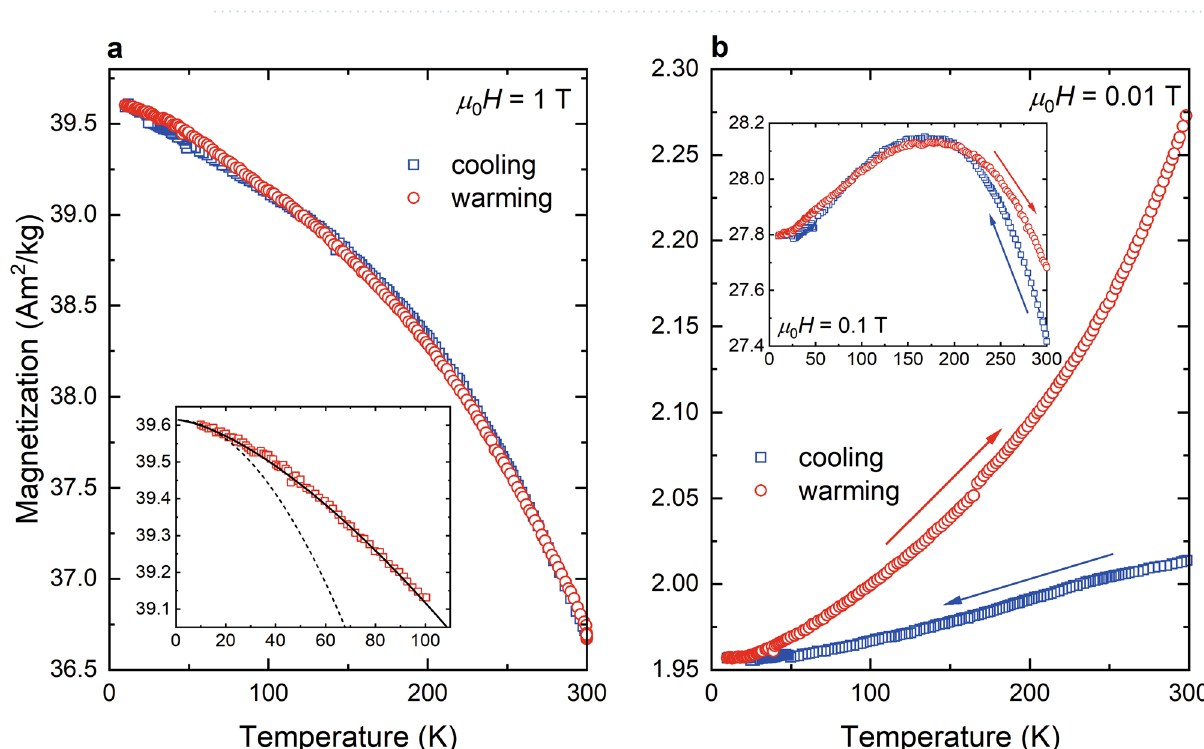
Figure 3. Low-temperature magnetization cycling. ( a ) Curves recorded in a 1 T field with inset shows the fit using the Bloch law with non-constraining T c (solid line), dashed line with T c = 600 K (see text). ( b ) curves recorded in a 10 mT field and a 100 mT field